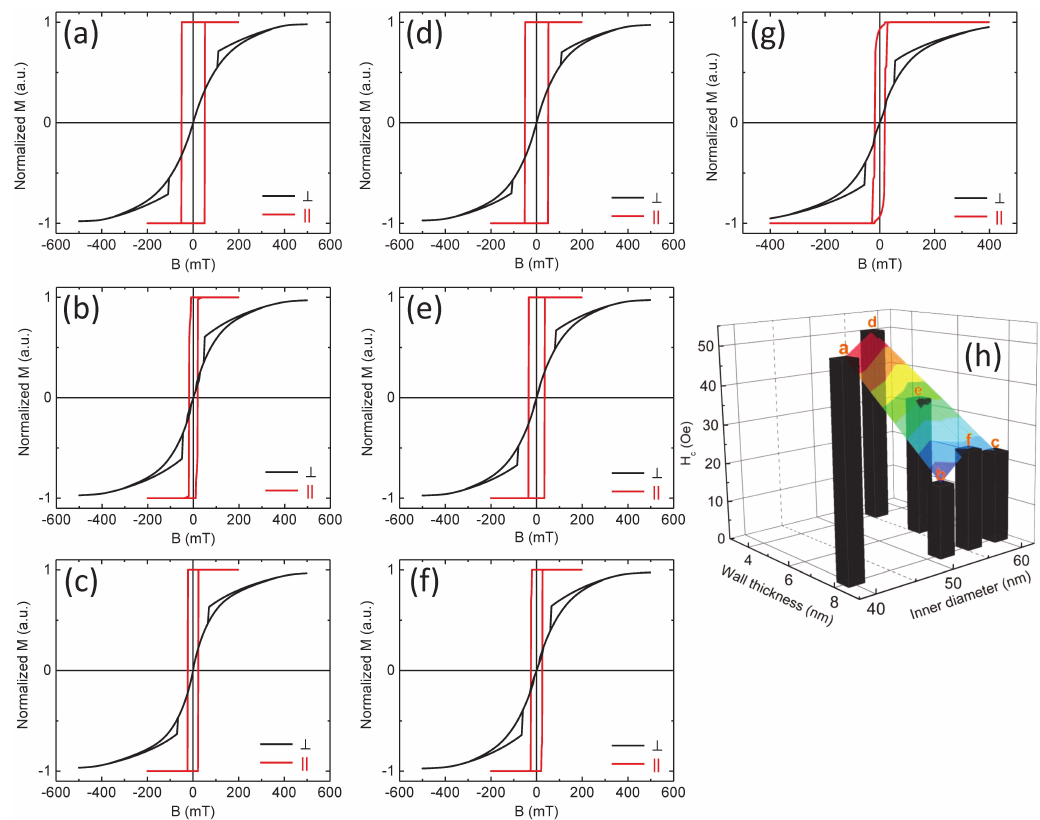
Figure 7. Simulated hysteresis loops of Ni NTs in parallel (red) and perpendicular (black) geometry obtained for the following geometrical parameters: 3 different inner diameters of 40 nm ( a ), 52 nm ( b ) and 60 nm ( c ) for a constant 8 nm wall thickness, as well as three different wall thicknesses of 4 nm ( d ), 6 nm ( e ) and 8 nm ( f ) for the same inner diameter of 56 nm. ( g ) Hysteresis loops for a system of 4 Ni NTs with a wall thickness of 14 nm, an inner diameter of 66 nm and center-to-center distance of 200 nm. ( h ) 3D representation of the theoretical H c as a function of wall thickness and inner diameter. The color of 3D surface representation suggests the highest (red) and lowest (blue) values of H c